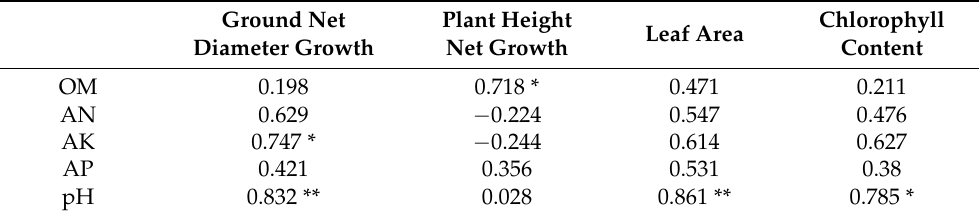
Table 1. Pearson’s analysis between seedling growth correlation indicators and soil nutrient content.